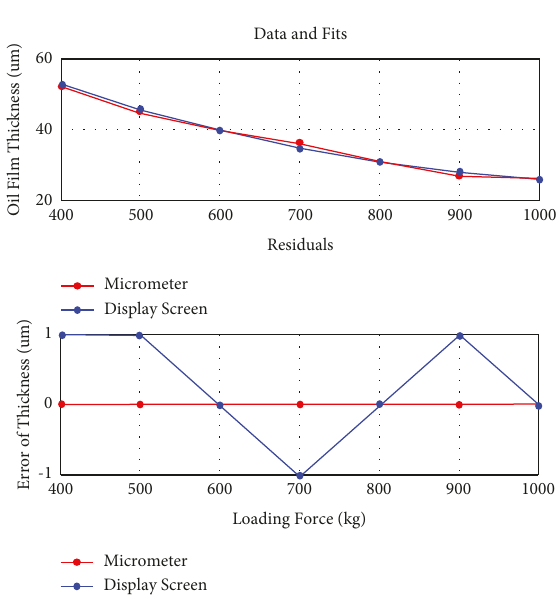
Figure 40: Detection accuracy following effect